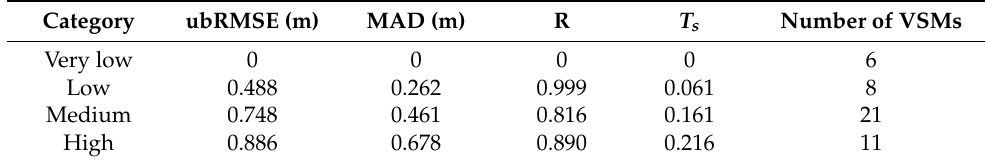
Table 3. Averaged metrics of all VSMs in West Africa by reliability category.